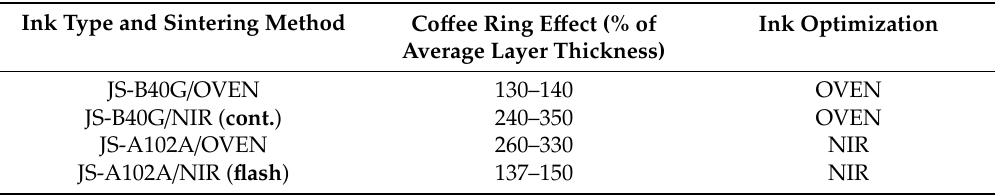
Table 2. Overview of the appearance of a co ff ee ring during di ff erent ink and sintering configurations. Using the appropriate sintering technique according to the ink type leads to a significant lower co ff ee ring e ff ect (130–150% instead of 240–350% of the average layer